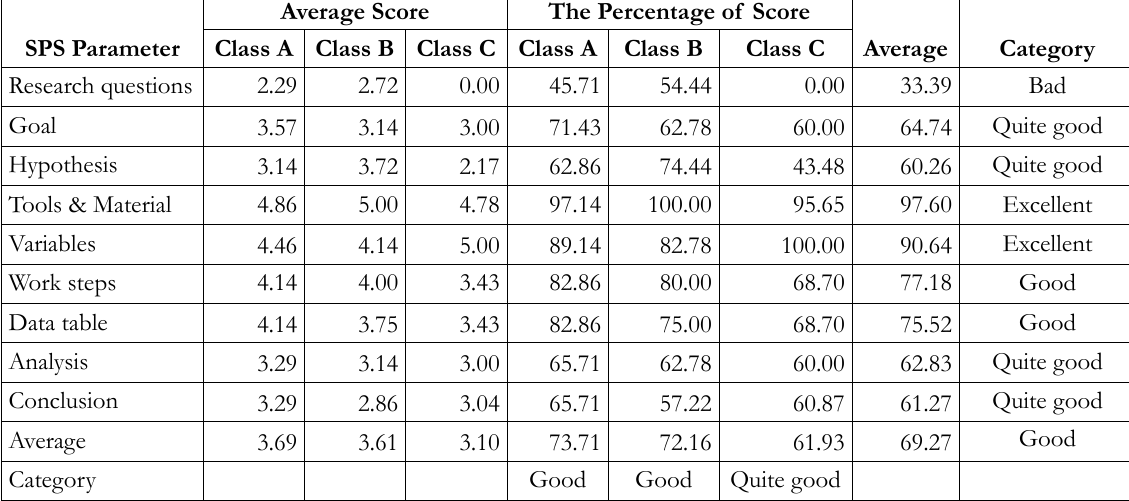
Table 4. The SPS average value data and categories based on the percentage of values